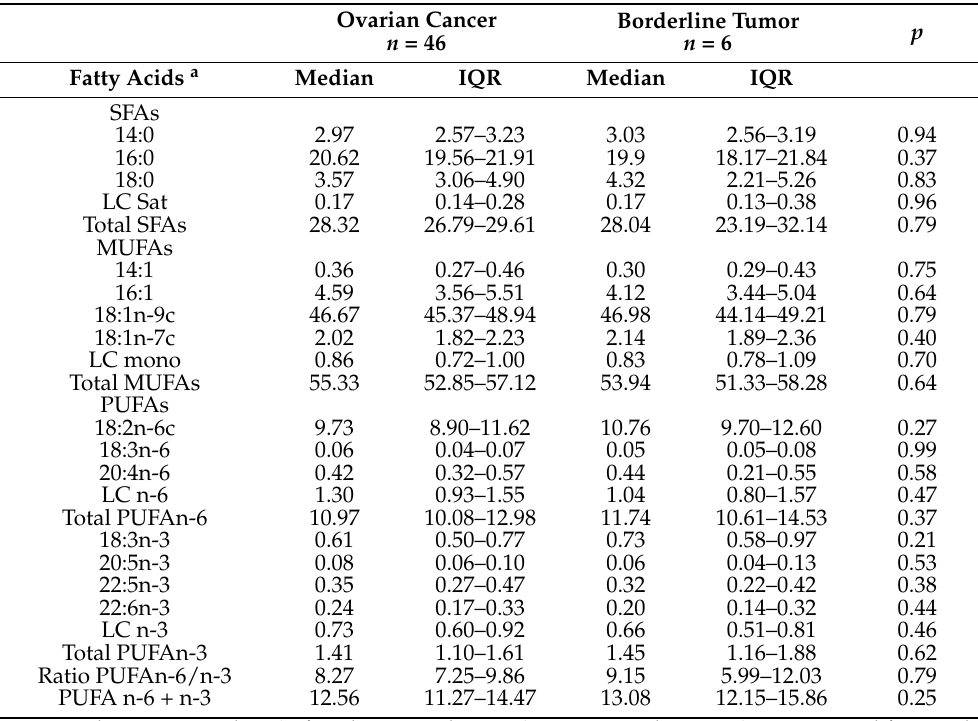
Table 2. Fatty acid composition of superficial subcutaneous adipose tissue of